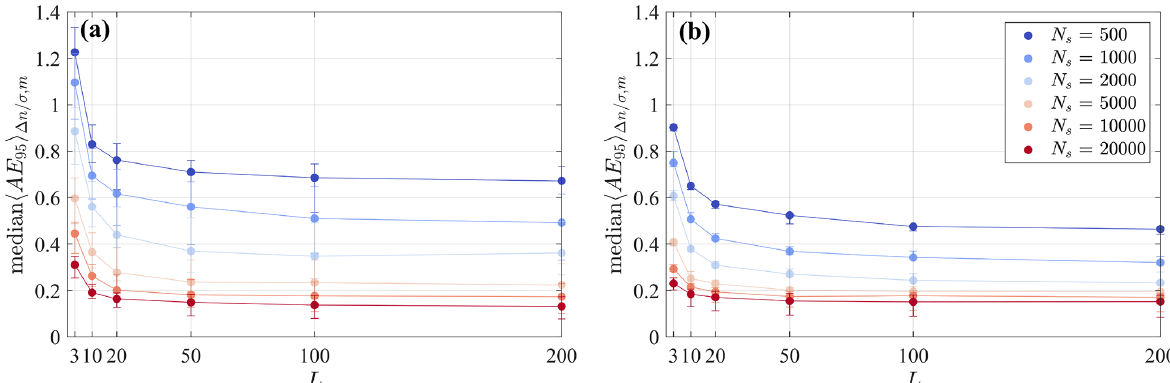
Figure 2. Median of the AE 95 for all the tested half wavelengths, (cid:49)n/σ , and the number of iterations, m . (a) AE 95 of the mean field, g m , and (b) AE 95 of the variance field, v m . The error bars span the interquartile range.